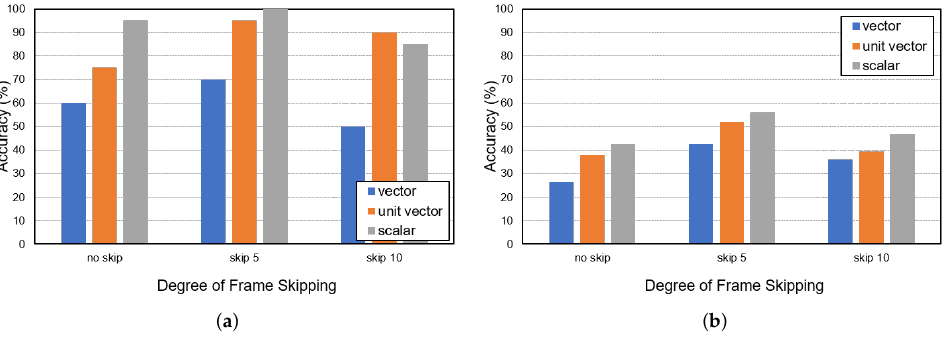
Figure 7. Global ID-matching accuracy with two cameras for ( a ) five persons and ( b ) ten